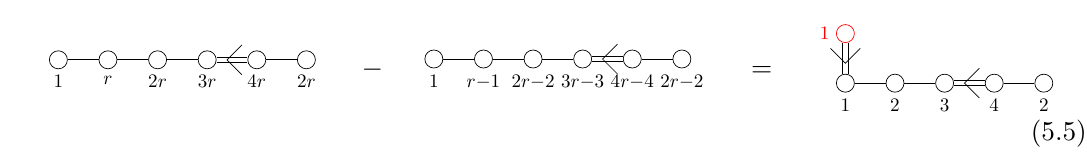
via quiver E 6 , 2 E 6 , 2